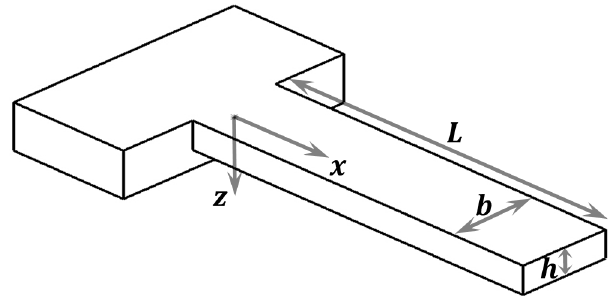
Figure 1. Schematic of a clamped-free beam. Cantilever with rectangular cross section where the width is denoted by (cid:1854) , the thickness by ℎ and the length by (cid:1838) . The axis (cid:1876) and (cid:1878) are also marked with the positive